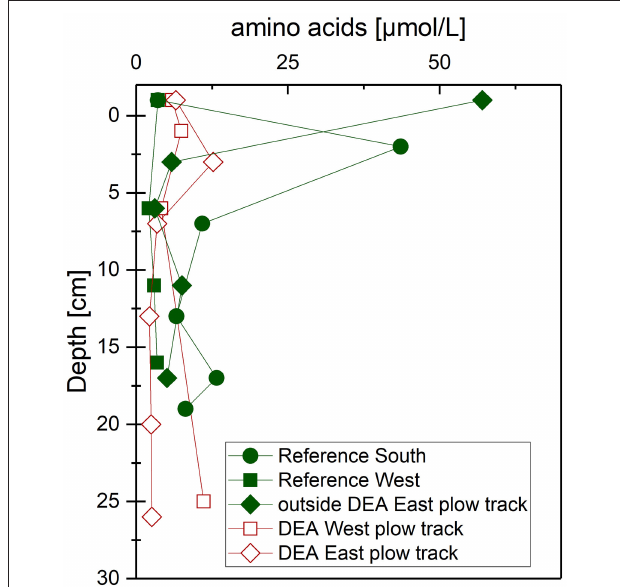
FIGURE 9 | Sum of dissolved amino acid (DAA) concentration profiles of three undisturbed and two disturbed sites. The uppermost values refer to bottom water concentrations measured in the supernatant retrieved above the sediment surface in the MUC liner.